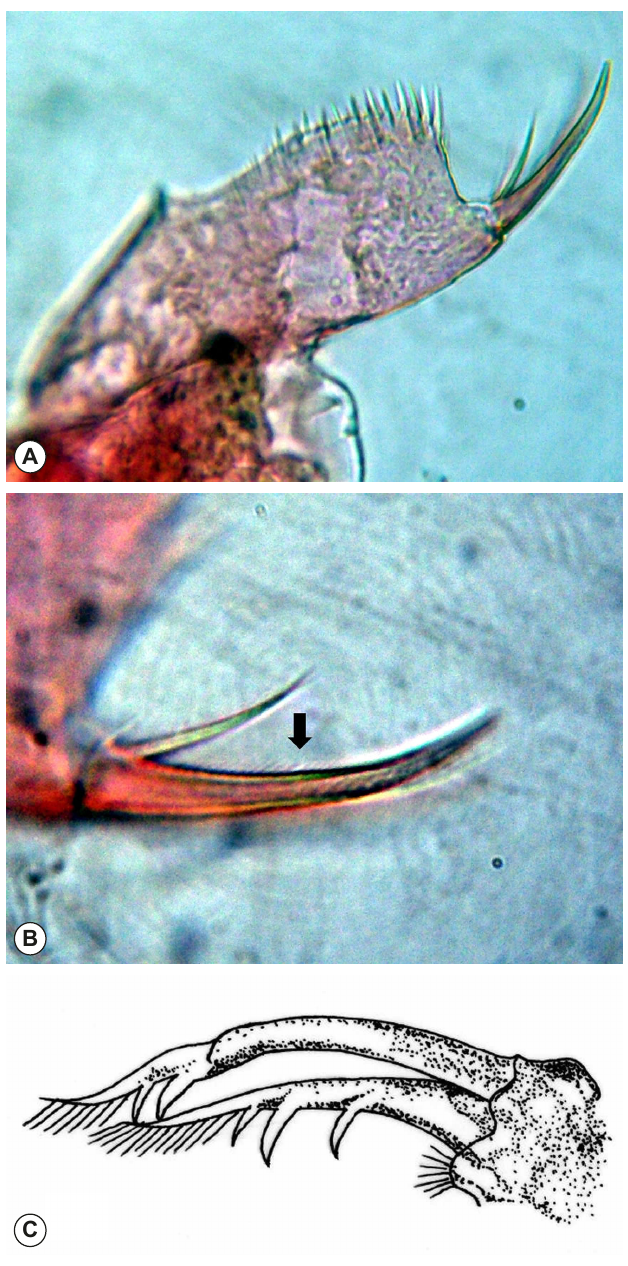
Figure 13. Coronatella monacantha. claw (The arrow points at fine pectens). C. IDL of trunk limb I.